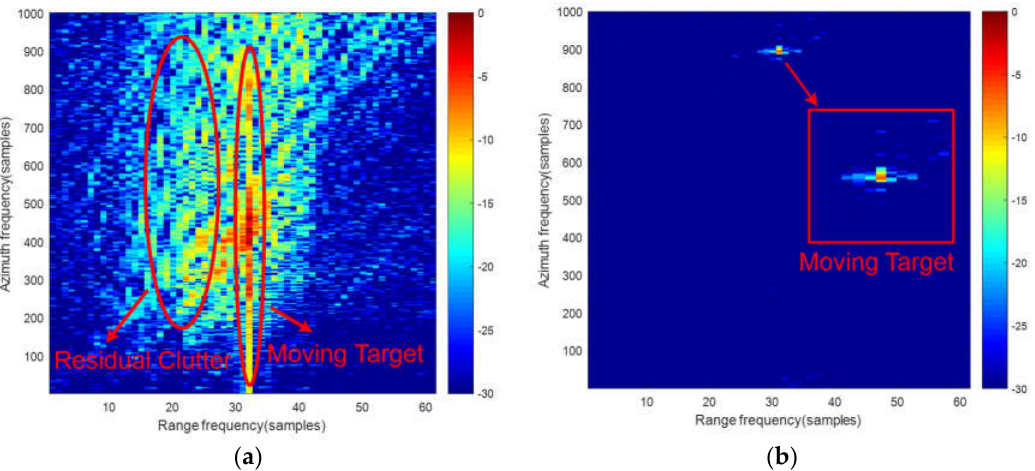
Figure 7. The result of joint clutter cancellation in echo-image domain: ( a ) the result of the first two-